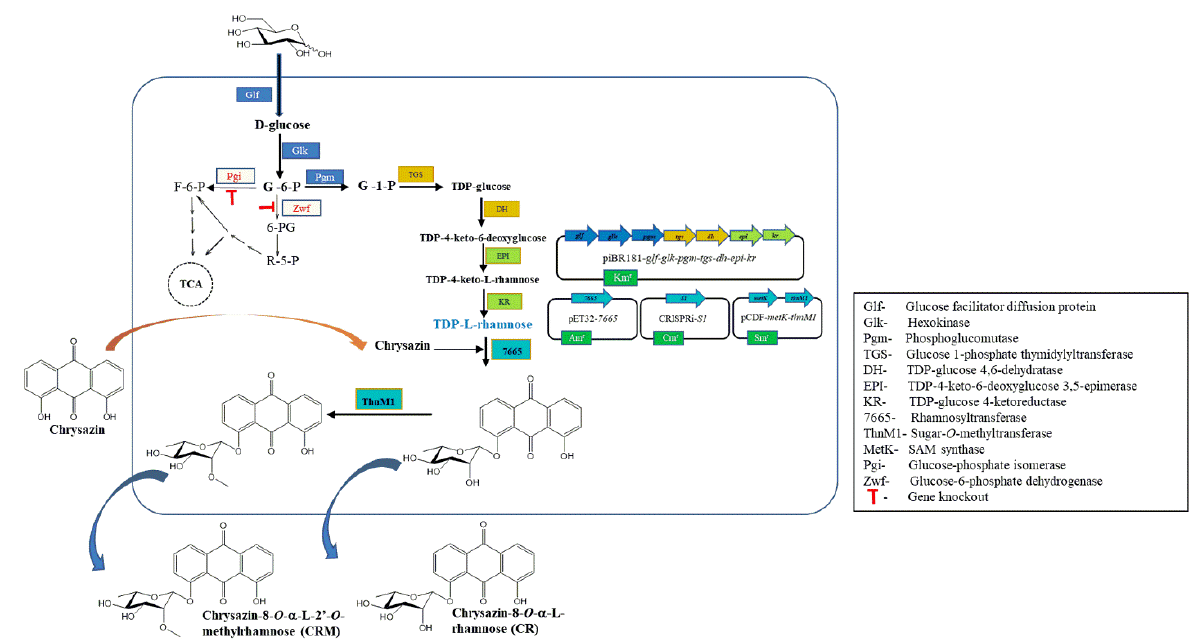
Figure 1. A scheme showing the pathway of utilizing recombinant Escherichia coli BL21(DE3) for the biosynthesis of chrysazin-8- O - α - L -rhamnoside (CR) and chrysazin-8- O - α - L -2 (cid:48) - O -methylrhamnoside (CRM) from chrysazin. Chromosomal pgi (glucose-phosphate isomerase) and zwf (glucose-6- phosphate dehydrogenase) genes were knocked-out. Chromosomal glk (hexokinase), pgm (phospho- glucomutase), tgs (glucose 1-phosphate thymidylyltransferase), dh (TDP-glucose 4,6-dehydratase), epi (TDP-4-keto-6-deoxyglucose 3,5-epimerase), and kr (TDP-glucose 4-ketoreductase) genes were over- expressed by cloning into pIBR181. 7665 (rhamnosyl transferase) was overexpressed by cloning into